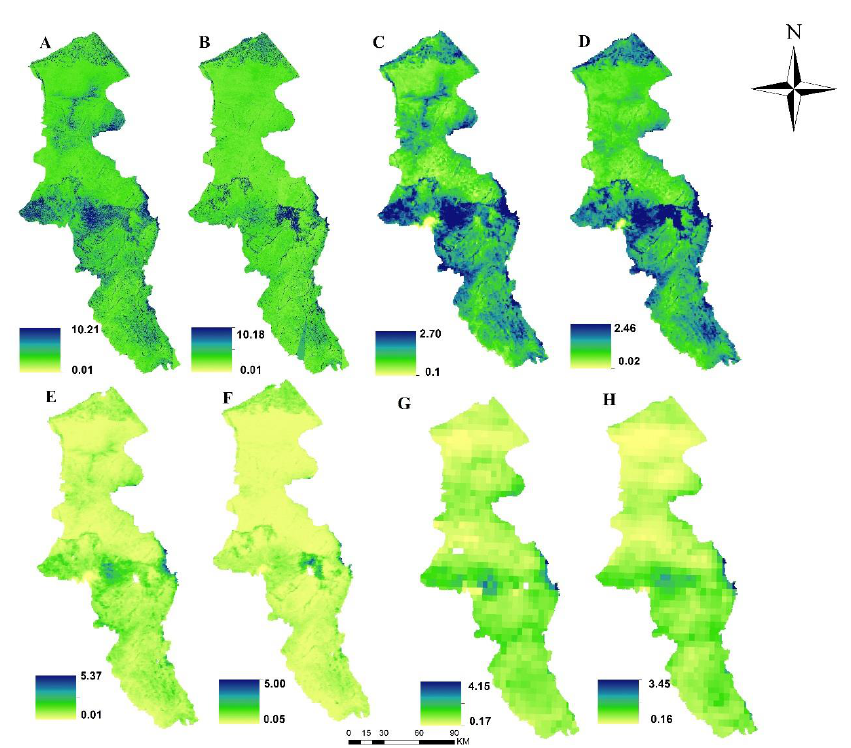
Figure 4. LAI estimated respectively in June and July 2020 using Sentinel-2 ( A , B ), Landsat 8 ( C , D ), MODIS ( E , F ), and AVHRR ( G , H ). Table 5. Accuracy assessment results for sampling months, PFTs, and different sensors.